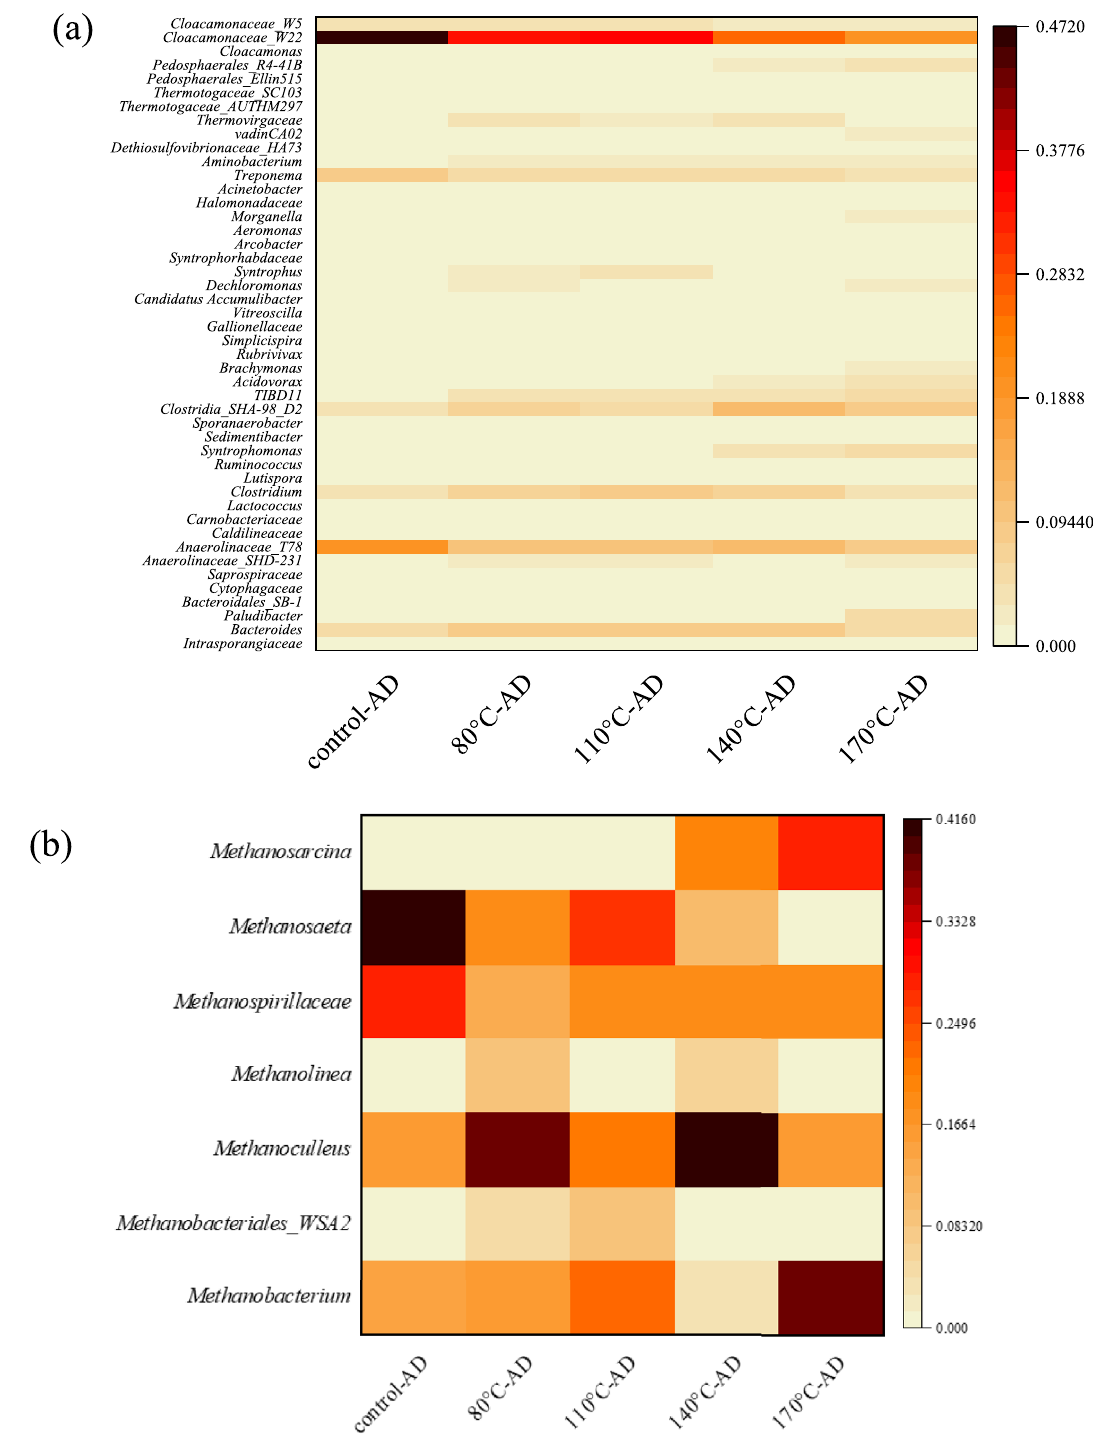
Figure 5. Relative abundance of ( a ) bacterial, ( b ) archaeal communities at the genus